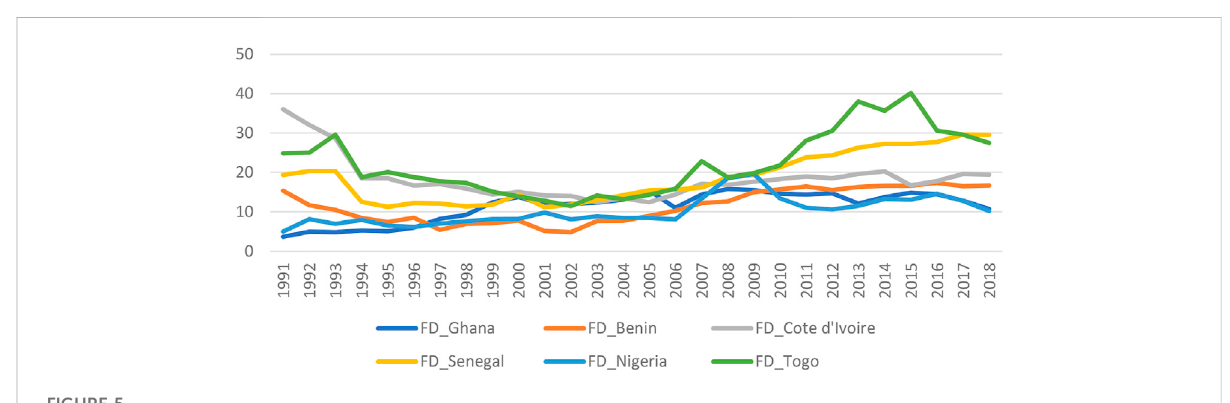
FIGURE 5 Financial development levels of West African